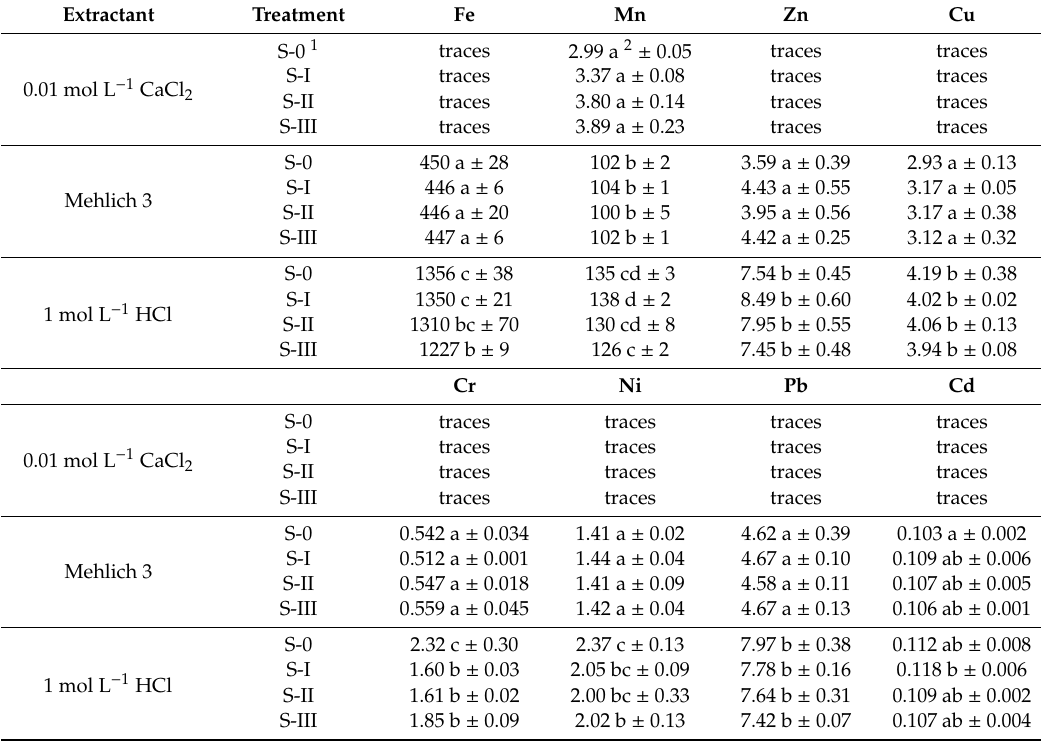
Table 7. Content of available forms of selected heavy metals in heavy soil 60 days after sulfur introduction (mg kg − 1 d.m. ±